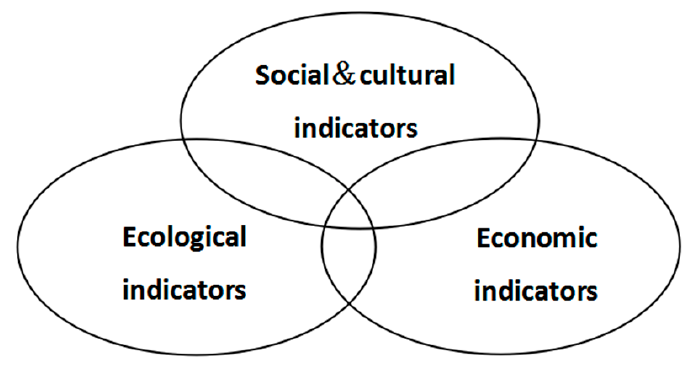
Figure 1. Melanen’s Eco-efficiency Framework.